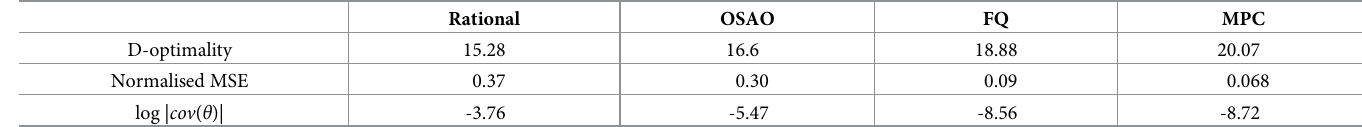
Table 2. Comparison of the performance of optimal experimental designs in supporting parameter inference for the auxotroph